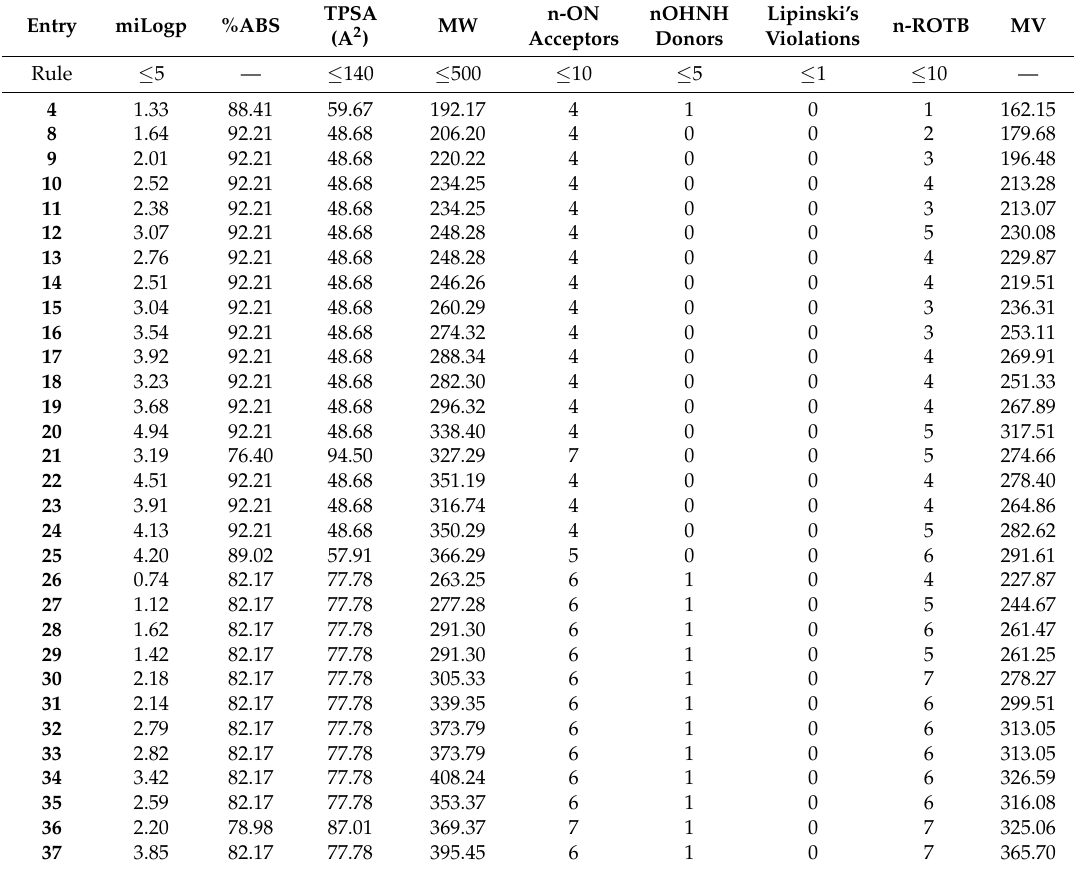
Table 9. Evaluation parameters of Lipinski’s rule of five and its extensions from scopoletin and its phenolic ether derivatives ( 8 – 37